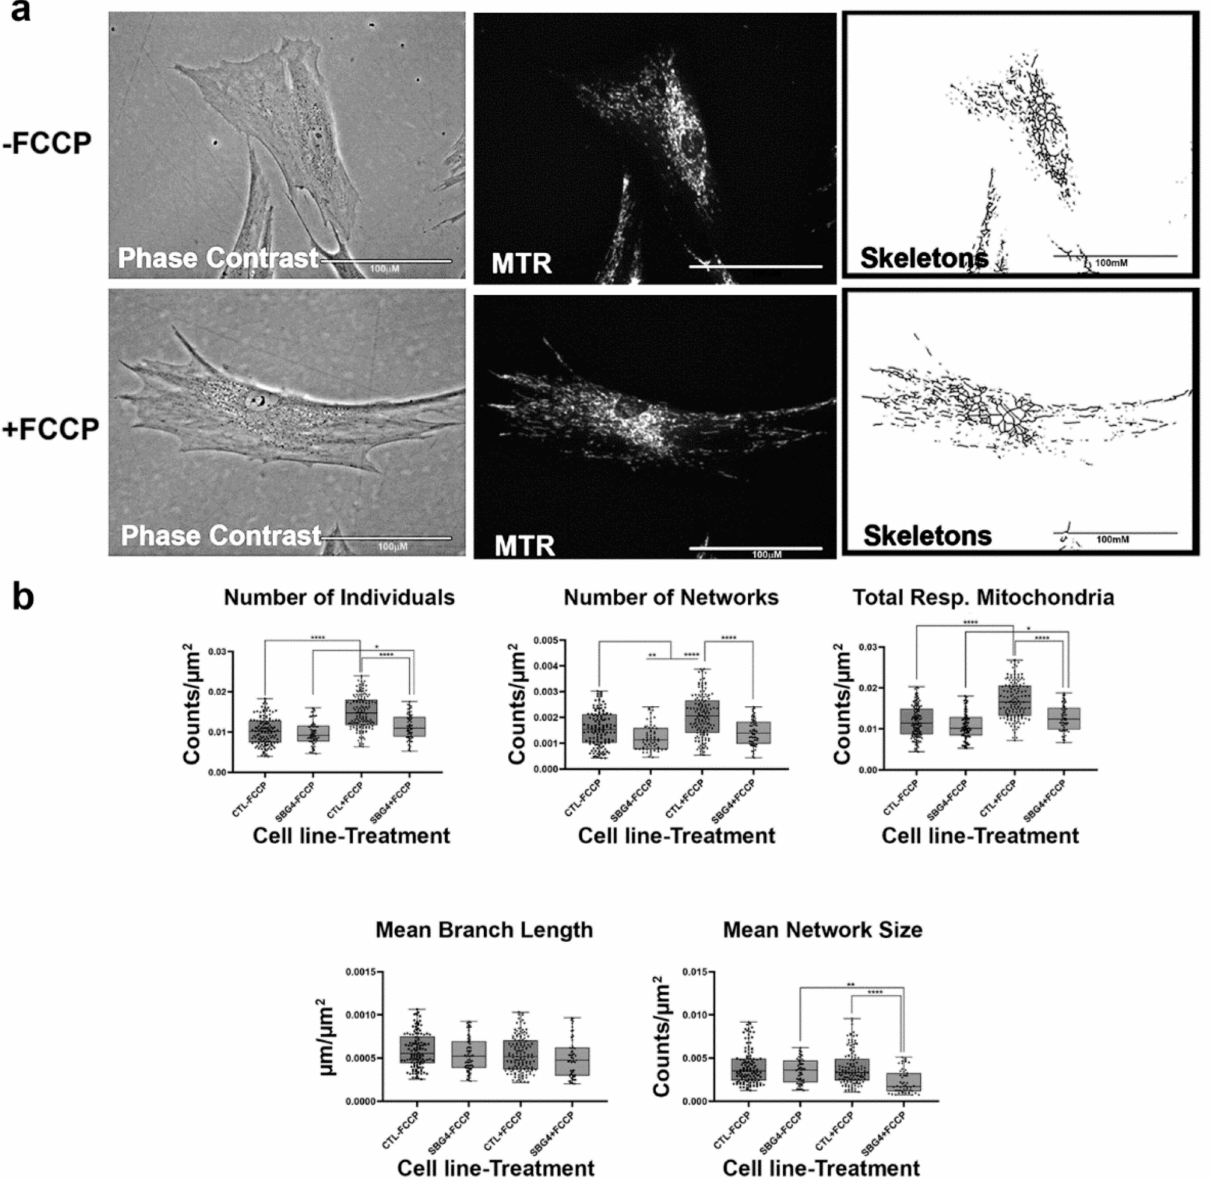
Figure 6. Mitochondrial morphology of SBG4 fibroblasts in the absence and presence of FCCP. ( a ) Representative images of SBG4 fibroblast cell lines stained with MTR. The top images are phase contrast, RFP, and skeletonized images of SBG4 fibroblasts without FCCP treatment. The bottom images are phase contrast, RFP, and skeletonized images of SBG4 fibroblasts with FCCP treatment. ( b ) Aside from having fewer networks, SBG4 fibroblasts are not significantly different from the control BJ fibroblasts. However, they are also responsive to FCCP treatment similar to the healthy control BJ fibroblasts. All data are representative of 10–14 images taken from three independent dishes per treatment group. The bars represent minimum and maximal values, and each black dot represents different data points. **** p < 0.0001, ** p < 0.01, * p < 0.05. Scale bar = 100 µ